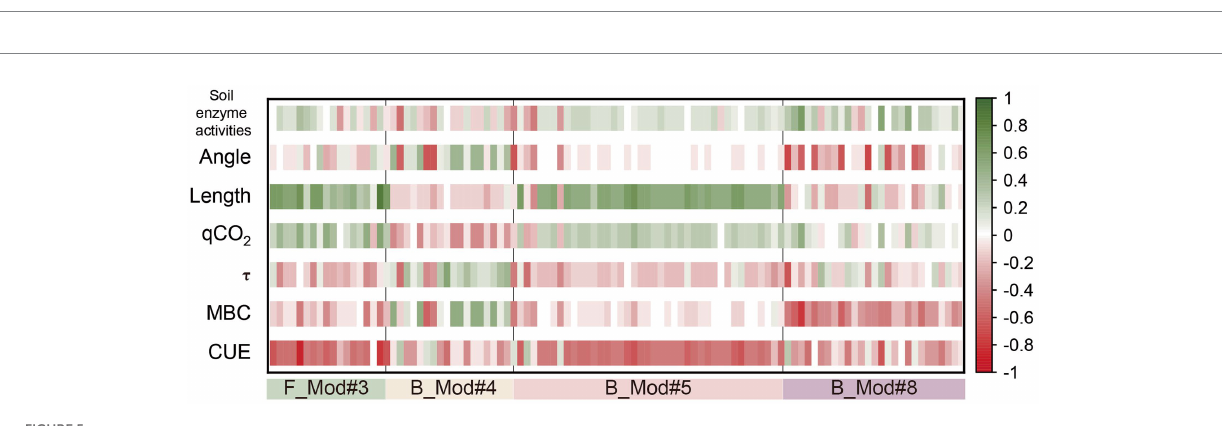
(Figure 6). The results showed that soil enzyme activities were significant predictors of CUE, MBC and qCO 2 (Figure 6A). Spearman’s correlation (Figure 6B) and redundancy analysis (Supplementary Figure S7B) further indicated that both CUE and MBC showed negative correlations with soil enzyme activities, while